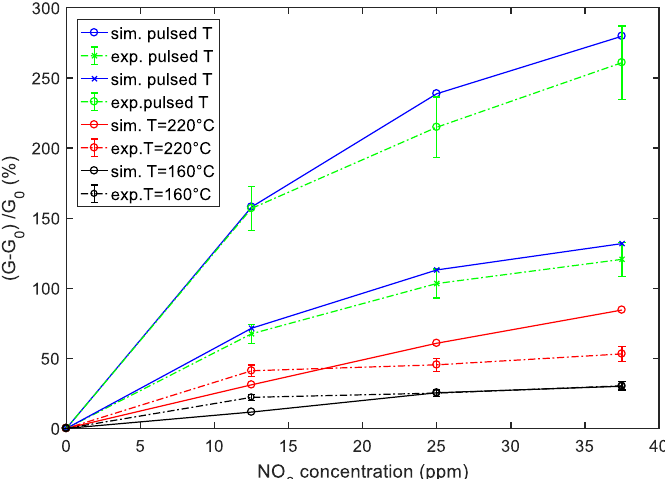
Figure 15. Simulation (solid lines) and experimental results (dashed lines) of the sensor response to NO 2 as a function of the NO 2 concentration for the SWCNT-TiO 2 sample. Blue color—sensor response obtained with pulsed temperature measurement profile; red color—sensor response with a constant temperature at 220 ◦ C, black color—sensor response with a constant temperature at 160 ◦ C as in Figure 8; the error bars refer to the estimated repeatability (approximately 10% of the response value).